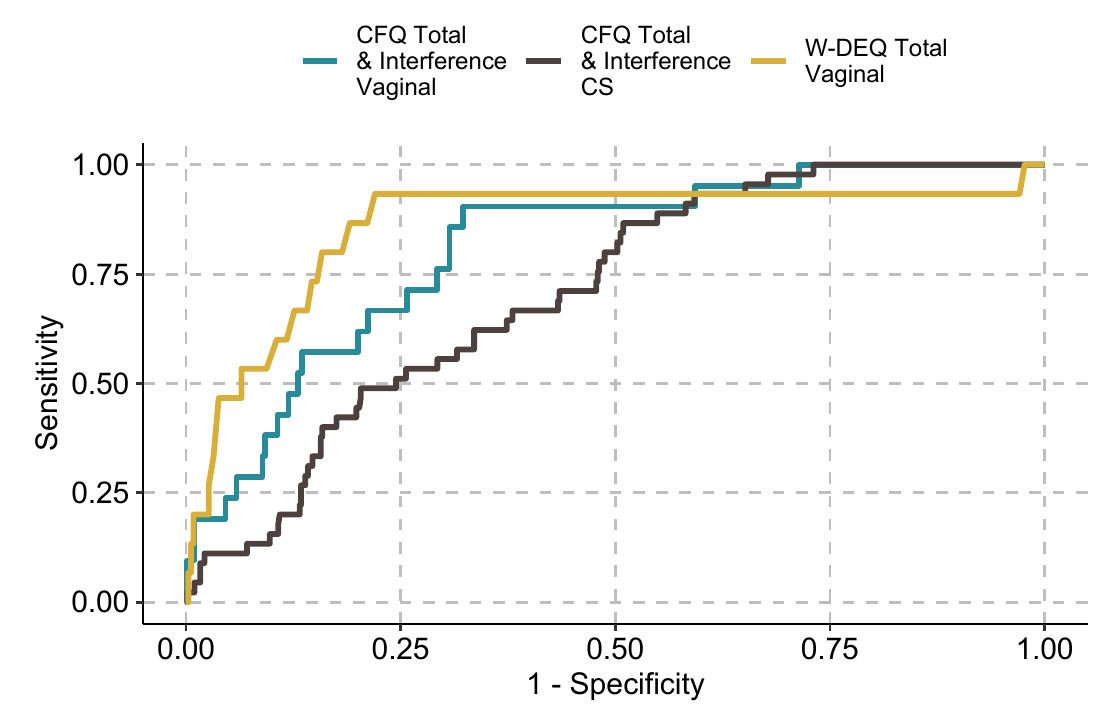
Figure 3. ROC curves for the CFQ (Total and Interference subscale scores) and the W-DEQ (subclinical and full diagnostic criteria combined).